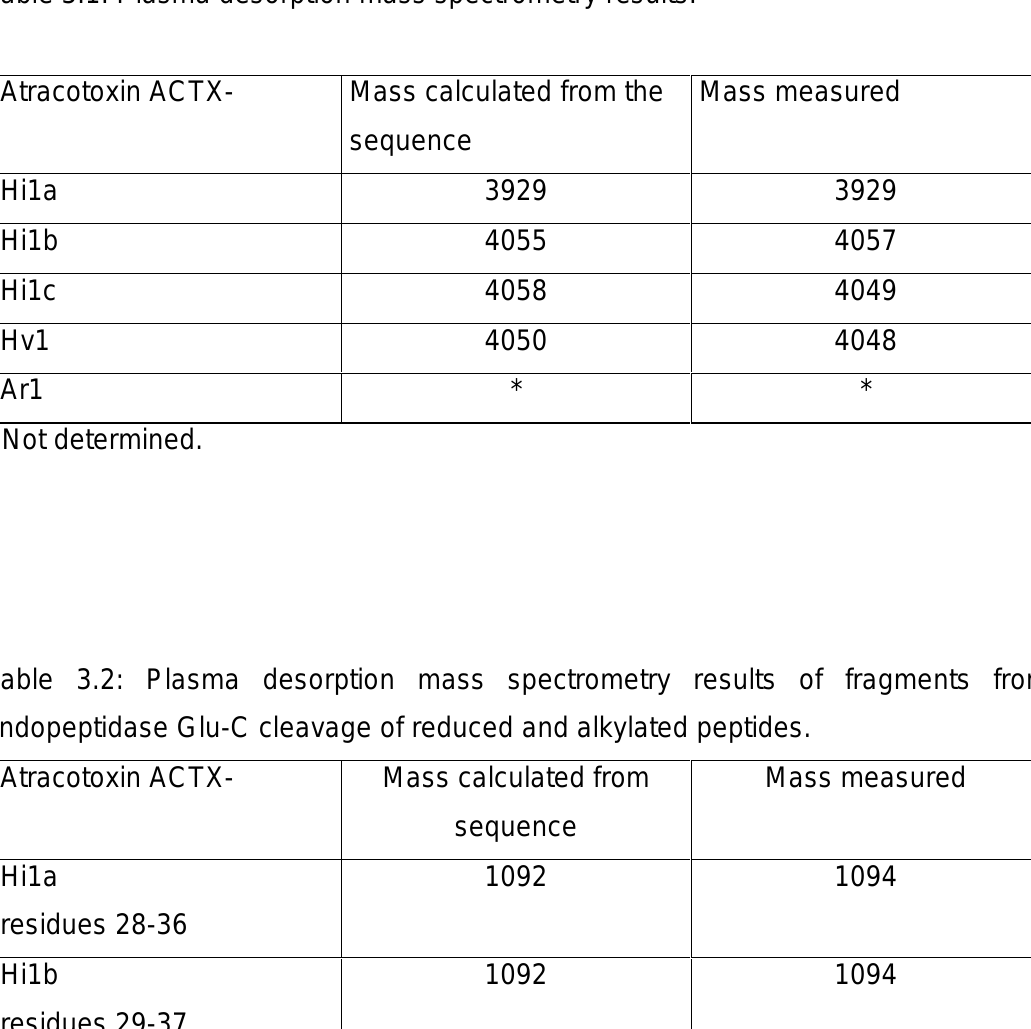
Table 3.1: Plasma desorption mass spectrometry results.